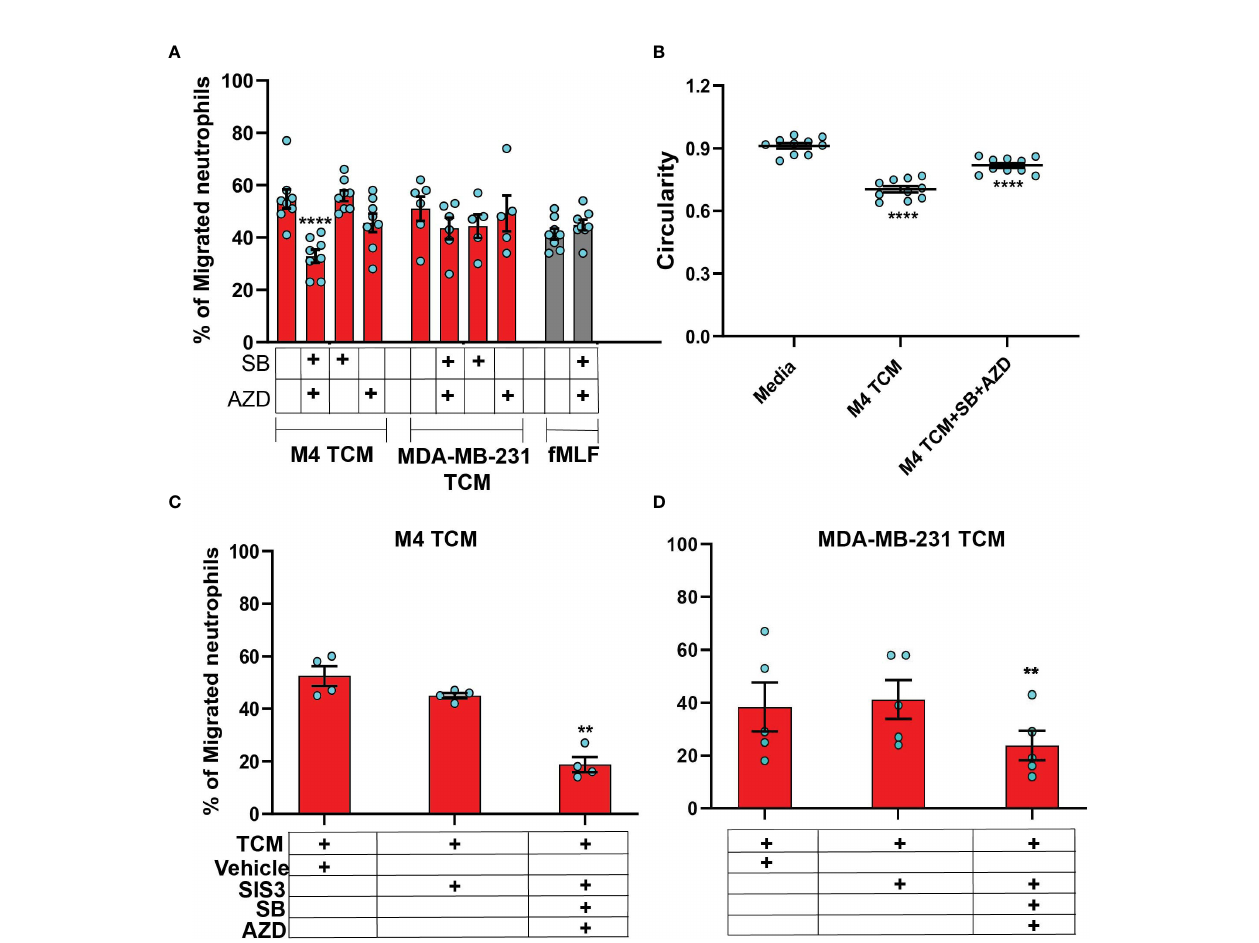
FIGURE 8 | The neutrophil recruiting activity of the TCM depends on the combined action of GRO chemokines and TGF- b . (A) Graph depicting the percentage of neutrophils either untreated or pretreated with 1 µM SB, 1 µM AZD, or a combination of 1 µM of SB and 1 µM AZD that migrated into the bottom chamber of the transwells containing equal volume of M4 TCM, MDA-MB-231 TCM, or 100 nM fMLF. Bars show mean ± SEM from N=5-8 donors with each dot representing individual donor. (B) Graph depicting the circularity of neutrophils exposed to M4 TCM in the presence or absence of a combination of SB and AZD, or with media control. Bars show mean ± SEM from N=3 donors with 3-4 dots for each donor representing mean circularity of all neutrophils from at least 3 randomly selected imaging fi elds. (C, D) Graphs depicting the percentage of neutrophils migrated into the bottom chamber of the transwells containing equal volume of M4 TCM (C) or MDA-MB-231 TCM (D) in the presence of 3 µM SIS3 alone or a combination of 1 µM each of SB, AZD and 3 µM SIS3, or vehicle control. Bars show mean ± SEM from N=4 (C) or 5 (D) donors. ****P < 0.0001 when compared with untreated (A) , media control (B) (one-way ANOVA with Dunnett ’ s multiple comparisons test). **P ≤ 0.01 when compared with vehicle control (C, D) (paired sample